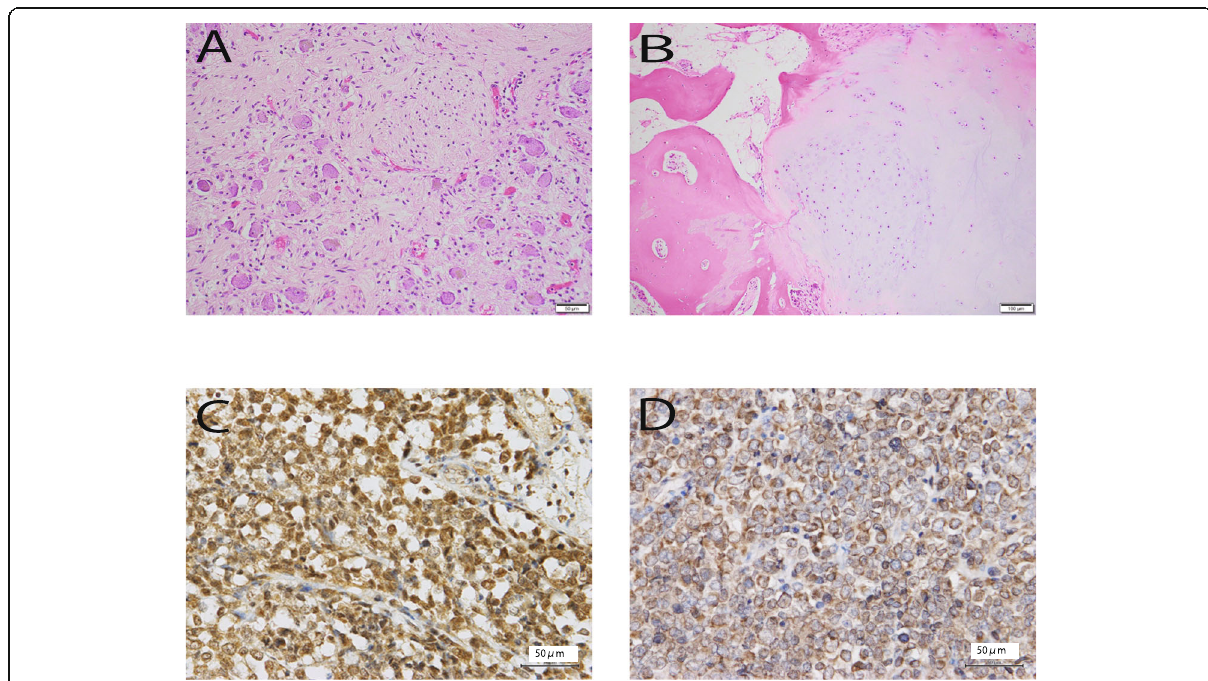
Fig. 3 Representative histological findings. A ganglioneuroma in the adrenal gland ( A ) and an enchondroma in the left clavicle ( B ) are shown. C Immunoreactivity to SLC7A11, with positivity in lymphocyte and tumor cell nuclei. D Immunoreactivity to ARID1A, with positivity in lymphocyte nuclei, partial positivity in the nucleus of tumor cells, and positivity in the cytoplasm of tumor